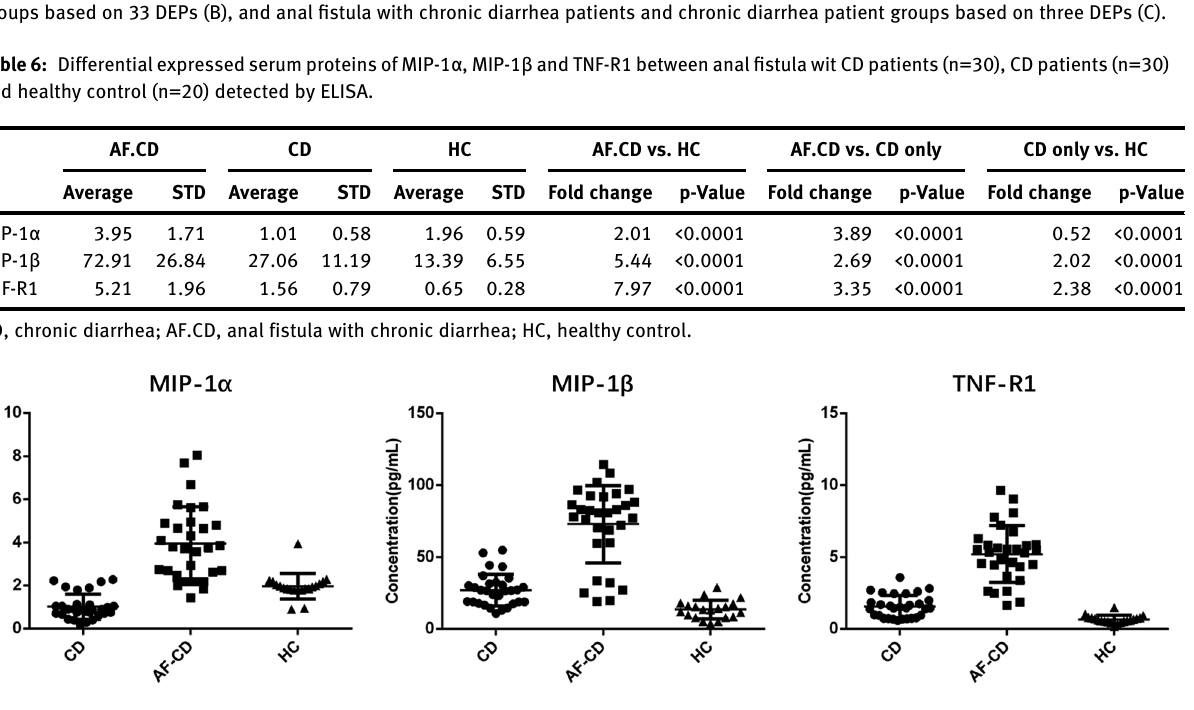
Figure5: ValidationofDEPsbyELISA.ThreeDEPs,MIP-1 α ,MIP-1 β andTNF-R1,werevalidatedbyELISAwithsamplesofanalfistulawithchronic diarrhea patients (n=30), chronic diarrhea patients (n=30) and healthy controls (n=20). AF.CD, anal fistula with chronic diarrhea; CD, chronic diarrhea; HC, healthy